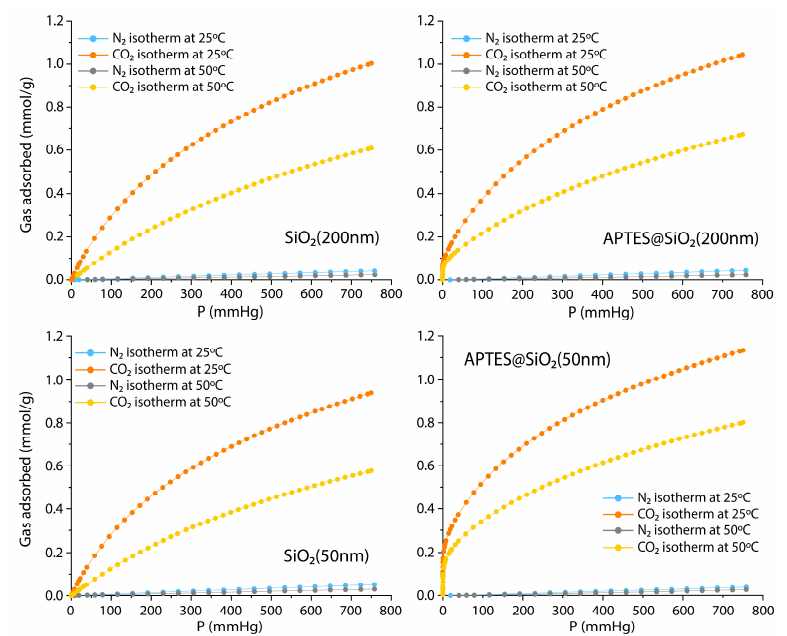
Figure 13. CO 2 and N 2 adsorption isotherms at 25 and 50 °C on pristine and functionalized SiO 2 nanoparticles of 50 and 200 nm size.